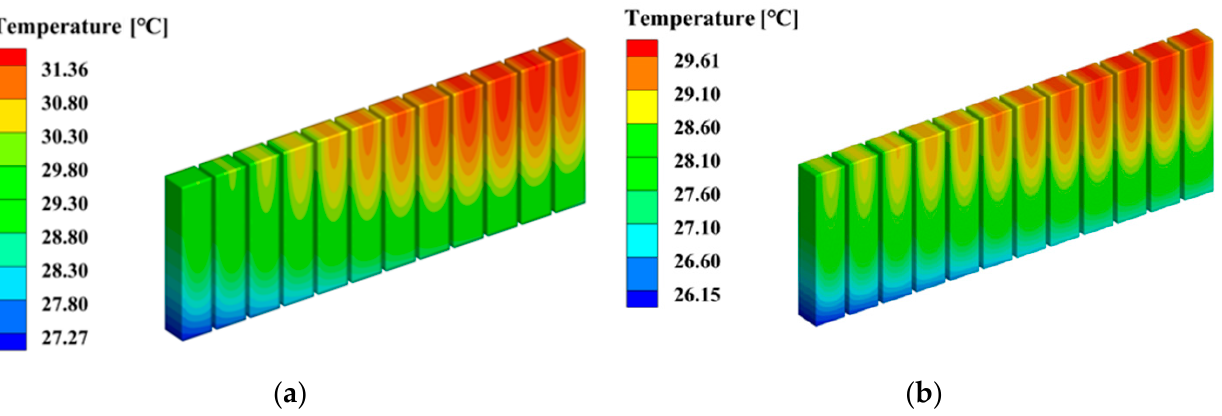
Figure 5. Temperature distribution of battery module: ( a ) straight channel and ( b ) wavy channel.